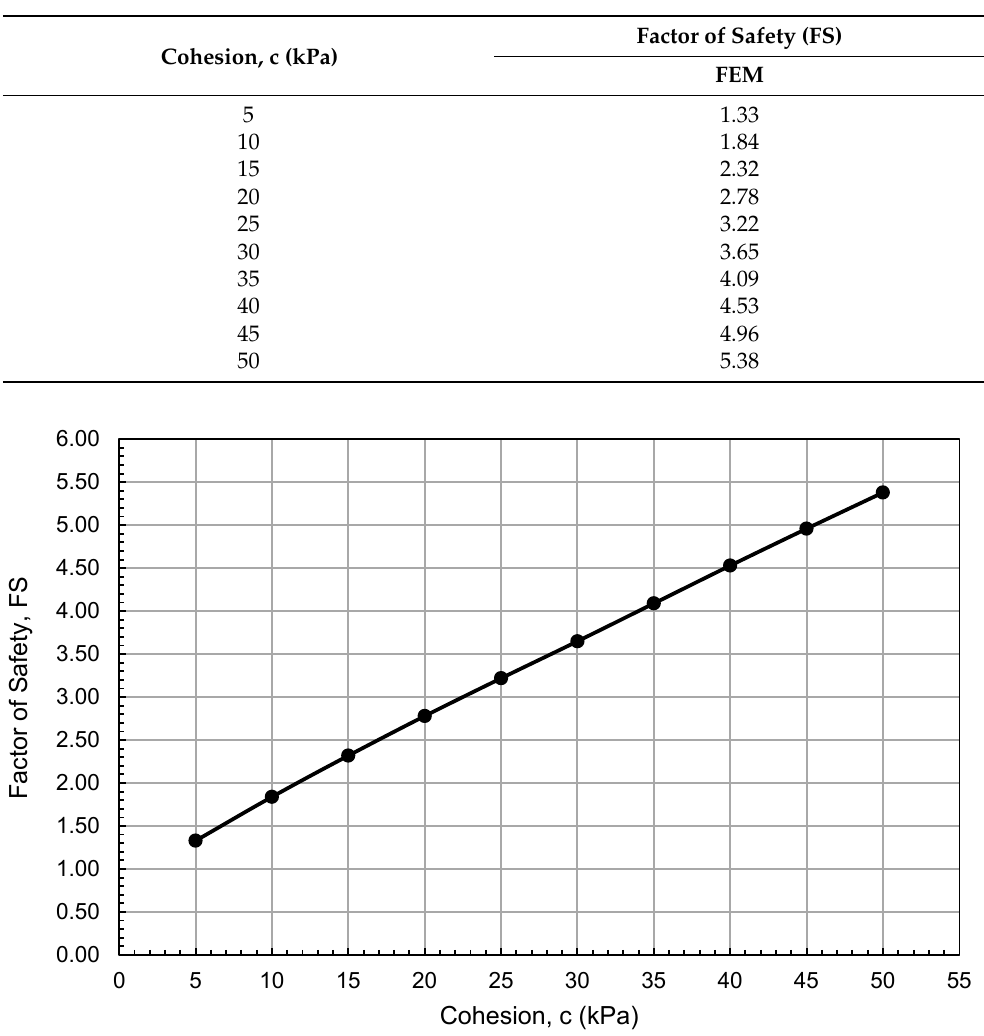
Figure 16. Variation in FS with c for the reinforced slope.